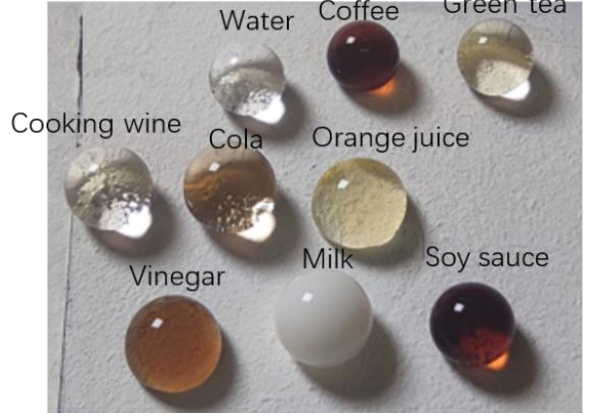
Figure 6. Morphology diagram and CA of different liquids on superhydrophobic surface, morphol- ogy